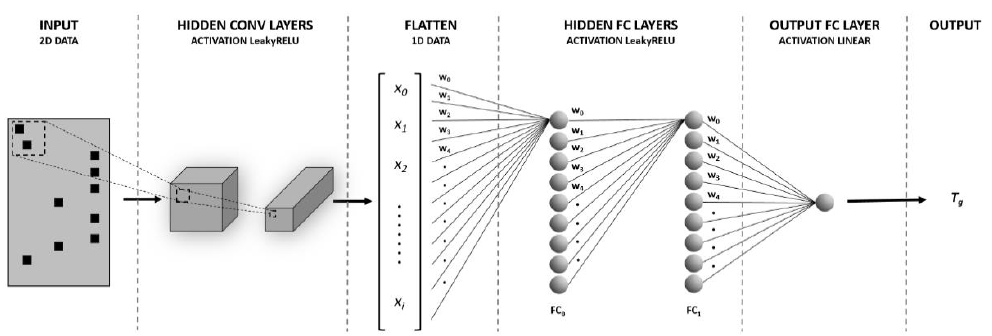
Figure 1. Schematic picture of the artificial neural network employed for predicting the glass transition temperatures of acrylates.